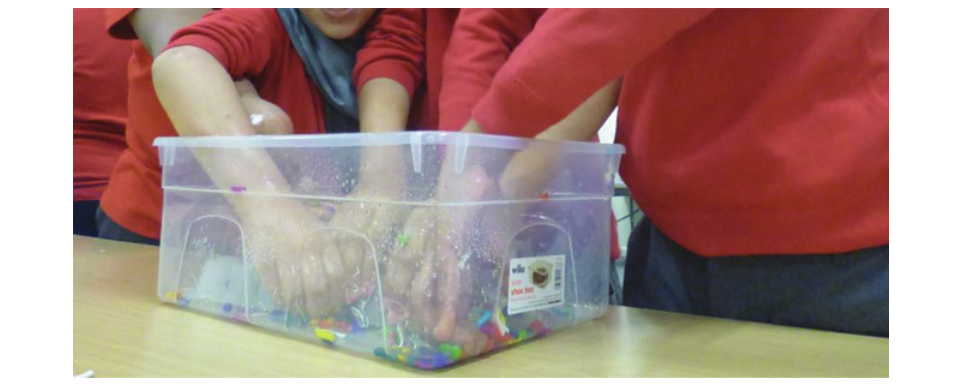
Figure 2: Pupils using the ‘blast a biofilm’ project, adapted from Victoria Marlow (Microbiology Society, 2017) (source: